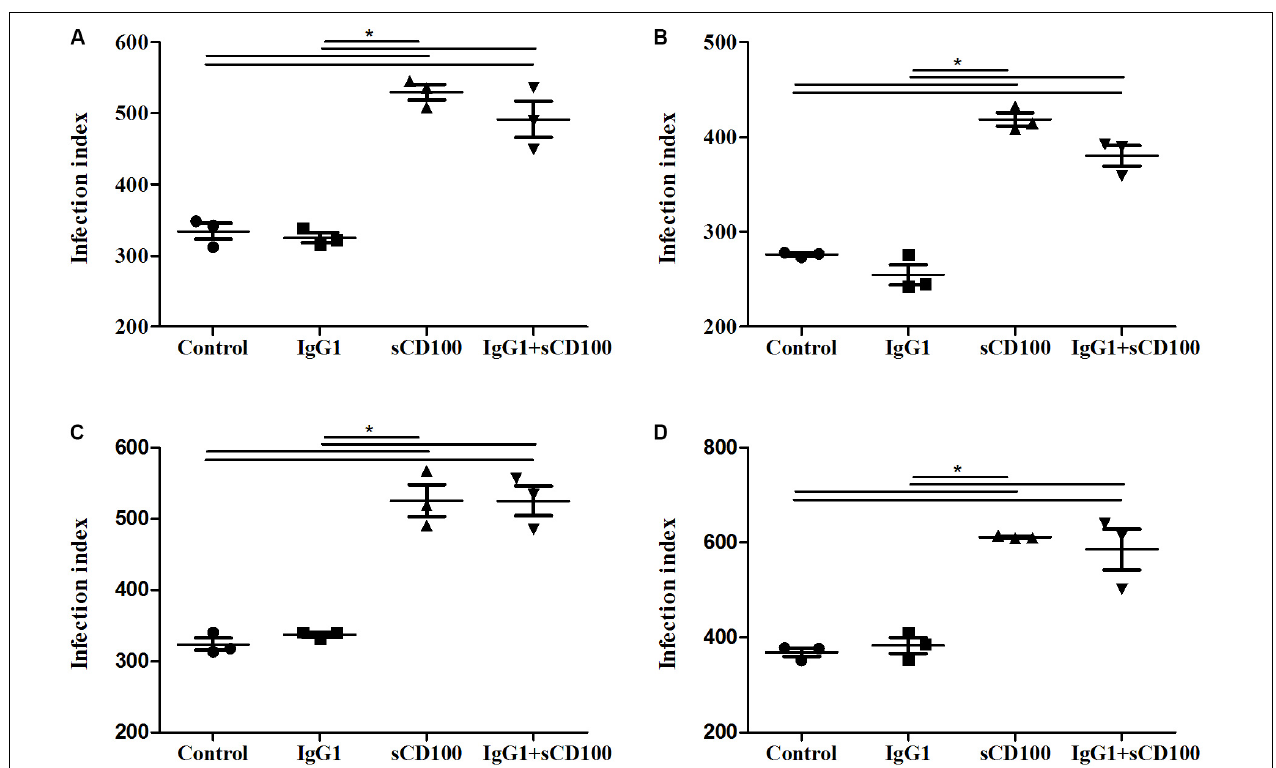
FIGURE 4 | Effects of IgG1 competition on infection index. Peritoneal macrophages from BALB/c mice were infected with L. (L.) amazonensis at a MOI of 5 for 4 (A) , 24 (B) , 48 (C) , and 72 (D) hours in the absence of stimulus (control), in the presence of 200 ng/mL of sCD100, 70 ng/mL of human IgG1 or IgG1+sCD100. Statistical analysis was performed by ANOVA with Tukey’s post-test, and significant differences are labeled as ∗ p ≤ 0.05. Results of a representative experiment of